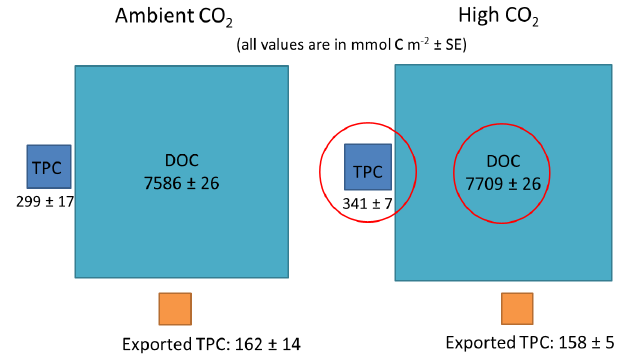
Figure 4. Standing stocks of total particulate carbon (TPC) and dis- solved organic carbon (DOC) at the last day of the experiment ( t43 ), plus the sum of exported TPC throughout the experiment; all values are in mmolCm − 2 ± SE ( n = 2). The values are averages of the two controls (M1 and M5) and the two highest CO 2 treatments (M3 and M8). Red circles indicate statistically significant higher stand- ing stocks in the high CO 2 treatments (further details in text). The size of the boxes indicates the relative size of the carbon standing stocks and